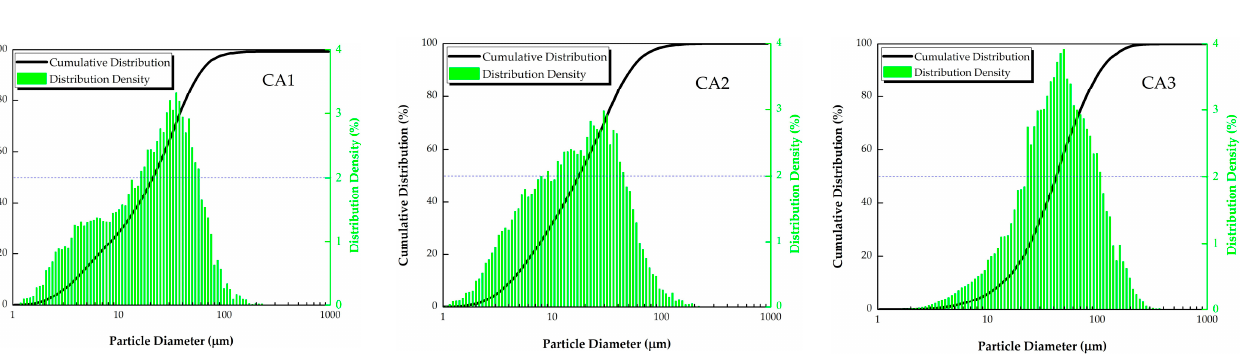
Figure 2. Particle size distribution of three coal ash